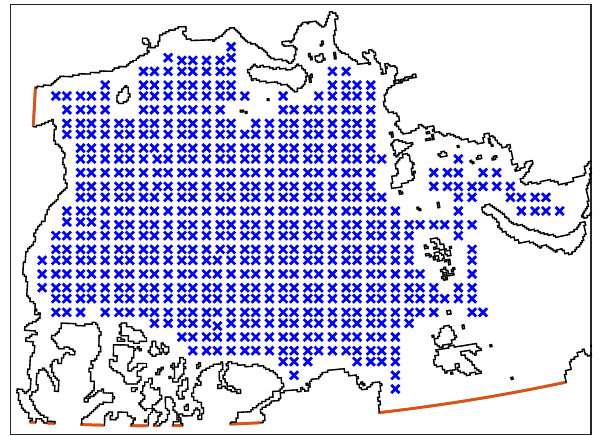
Figure 3. Maps showing the Arctic domain considered for this study. The red lines are open boundaries, while the black coastlines are closed boundaries. The starting points of the virtual trajectories simulated with the neXtSIM and FD models are represented by the blue crosses.